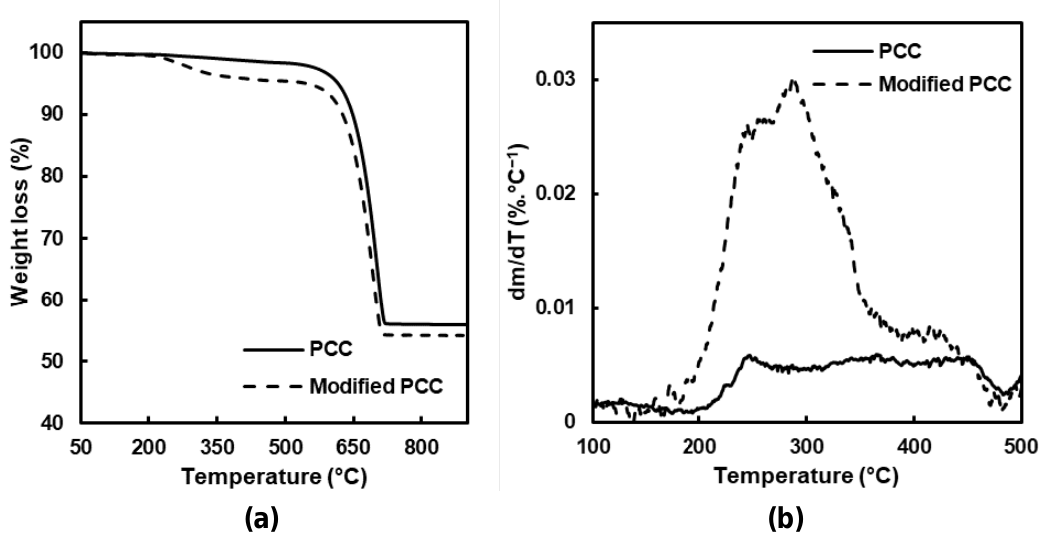
Figure 3. ( a ) TGA and ( b ) dTGA of PCC before and after modification.